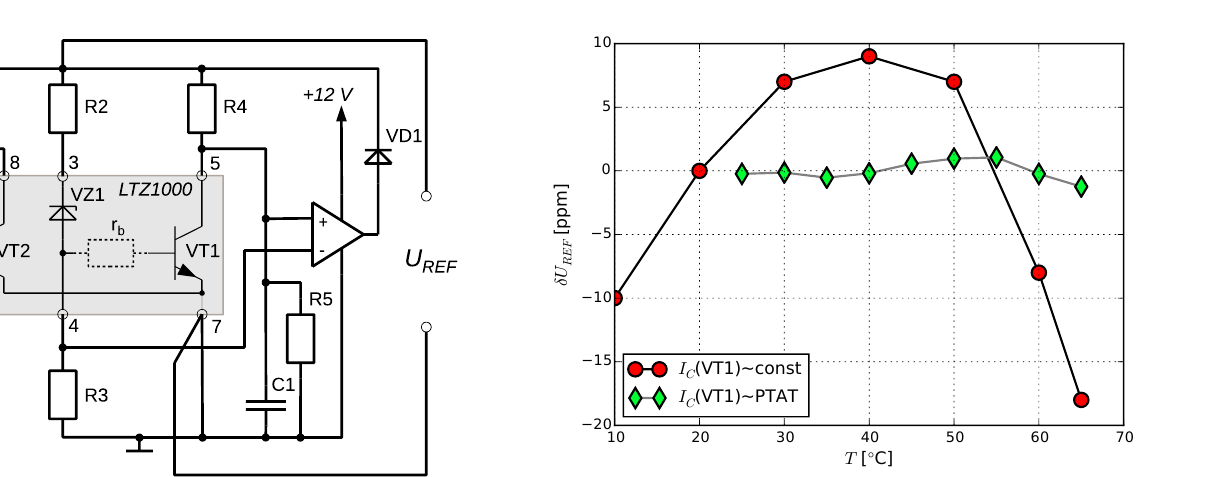
Figure 4. LTZ1000 configuration.